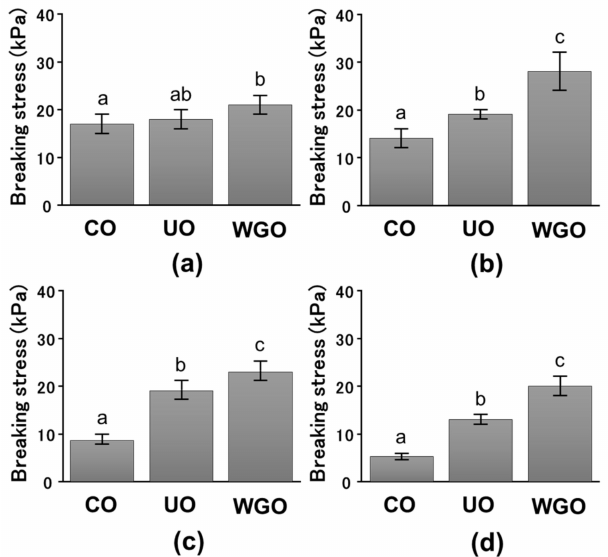
Figure 1. Breaking stress in okara–soybean protein isolate (SPI) gels. ( a ), 3% okara–SPI gels; CO, control SPI gel (15.52% SPI); UO, wet-type grinder (WG)-untreated okara–SPI gel (15.52% SPI and 0.48% WG-untreated okara); WGO, WG-treated okara–SPI gel (15.52% SPI and 0.48% WG-treated okara). ( b ), 5% okara–SPI gels; CO, control SPI gel (15.20% SPI); UO, WG-untreated okara–SPI gel (15.20% SPI and 0.80% WG-untreated okara); WGO, WG-treated okara–SPI gel (15.20% SPI and 0.80% WG-treated okara). ( c ), 10% okara–SPI gels; CO, control SPI gel (14.40% SPI); UO, WG-untreated okara–SPI gel (14.40% SPI and 1.60% WG-untreated okara); WGO, WG-treated okara–SPI gel (14.40% SPI and 1.60% WG-treated okara). ( d ), 15% okara–SPI gels; CO, control SPI gel (13.60% SPI); UO, WG-untreated okara–SPI gel (13.60% SPI and 2.40% WG-untreated okara); WGO, WG-treated okara– SPI gel (13.60% SPI and 2.40% WG-treated okara). Different letters indicate significant differences ( p < 0.05).